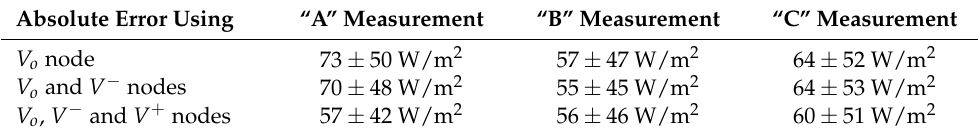
Table 13. Absolute error from H reconstruction by different nodes usage. Absolute Error Using “A” Measurement “B” Measurement V o